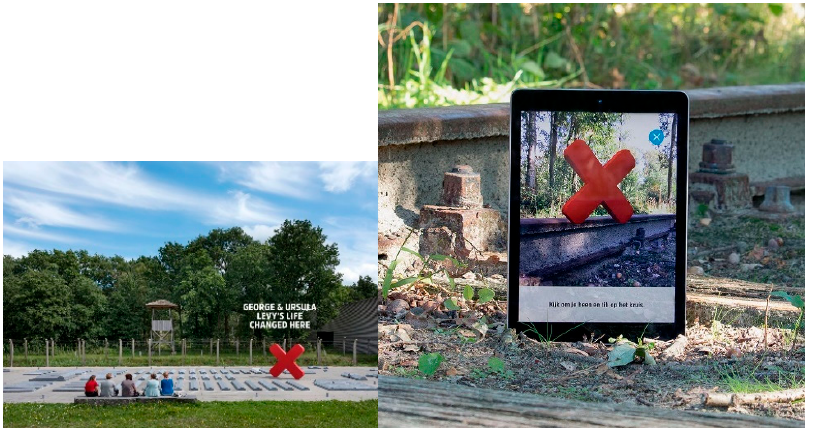
Figure 3. Kamp Vught, where the story of George and Ursula took place ( left ) and the AR video starting screen ( right ). (Reprinted with permission from ©BrabantRemembers).